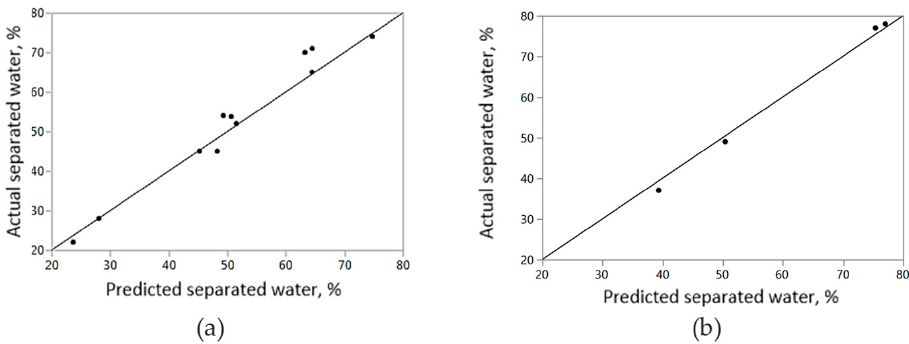
Figure 7. Experimental versus the predicted water separation. ( a ) Training, ( b ) validation.